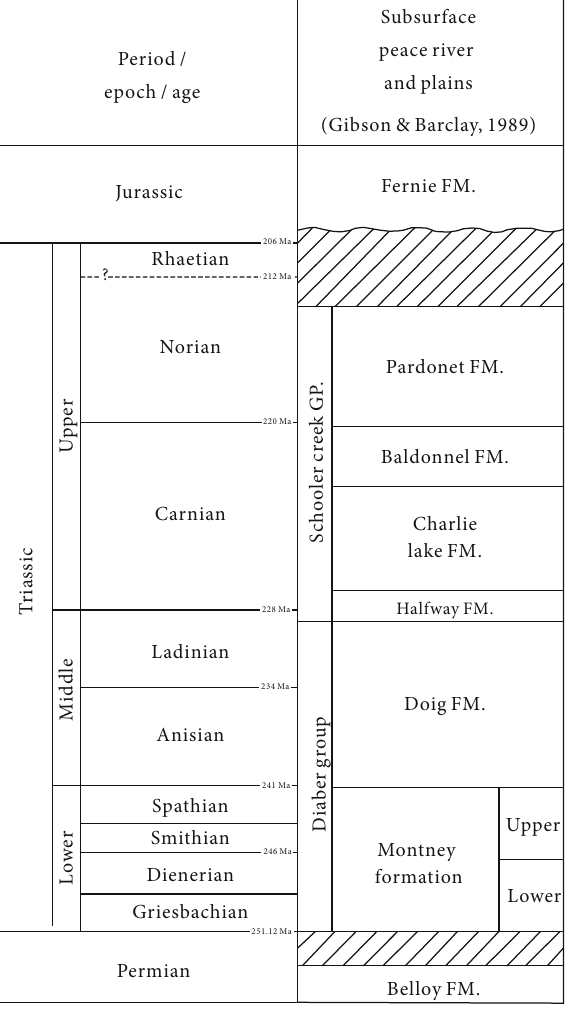
Figure 3: Stratigraphic chart of the Montney Formation. In this study, Diaber group of Montney Formation has divided into upper and lower member based on lithological characters (modi fi ed Yang and Lee